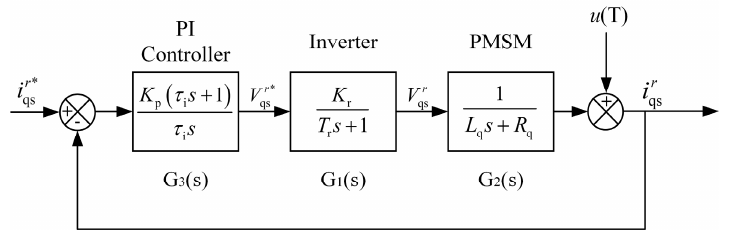
Figure 9. System block diagram with the disturbance injected.